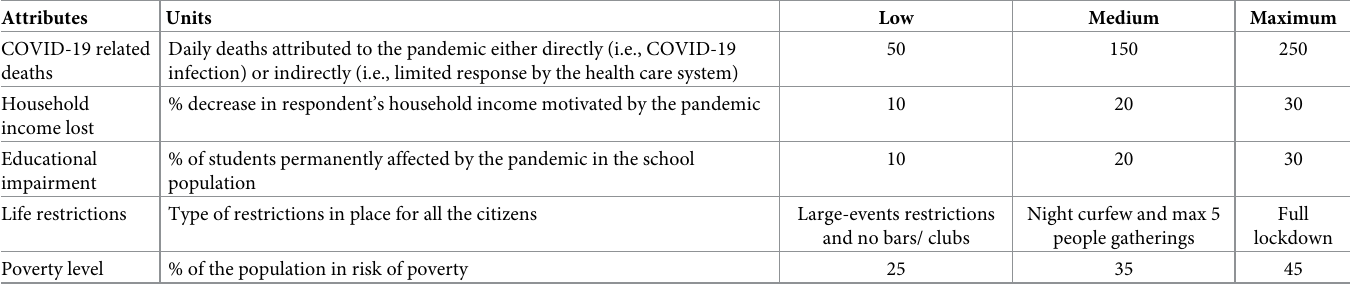
Table 1. Attributes and levels of the survey for the period between January and June